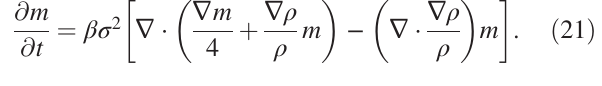
FIG. 14. Radial cross sections (along the line y ¼ 0 ) through numerical approximations to fundamental solutions of the modified OJK equation (21) with population distribution ffiffiffiffiffiffiffiffiffiffiffiffiffiffiffi p x 2 þ y 2 Eq. (20) at time t ¼ 300 . Here, r ¼ ¼ x . Parameter values are βσ 2 ¼ 1 and R ¼ 10 . Initial conditions are r 0 ¼ ð 1 ; 0 Þ ; ð 10 ; 0 Þ ; ð 20 ; 0 Þ (solid, dashed, dotted lines,